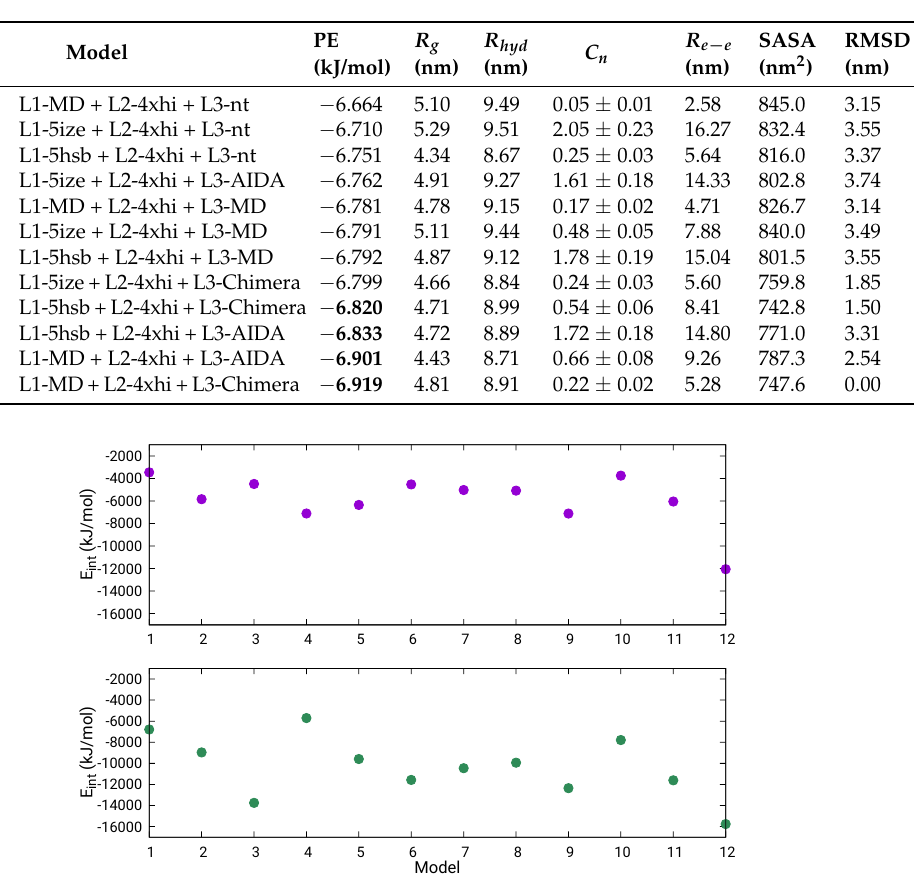
Table 4. Potential energy per atom PE, radius of gyration R g , hydrodynamic radius R hyd , flexibility coefficient C n , end-to-end distance R e − e , and solvent-accessible surface area SASA of RVFV L protein structural models. Values correspond to relaxed structures after minimization. Models provided in decreasing PE order. Last column lists the root-mean-squared deviation (RMSD) of each model with respect to the most energetically